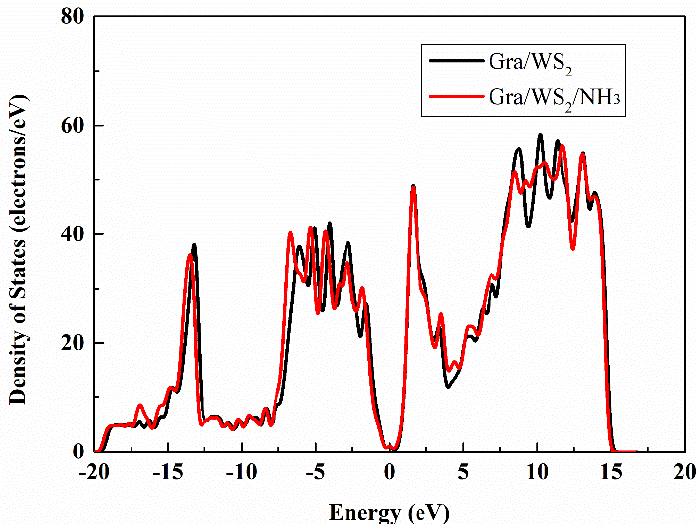
Figure 3. Calculation of the total density of states of graphene/WS 2 before and after NH 3 adsorption.